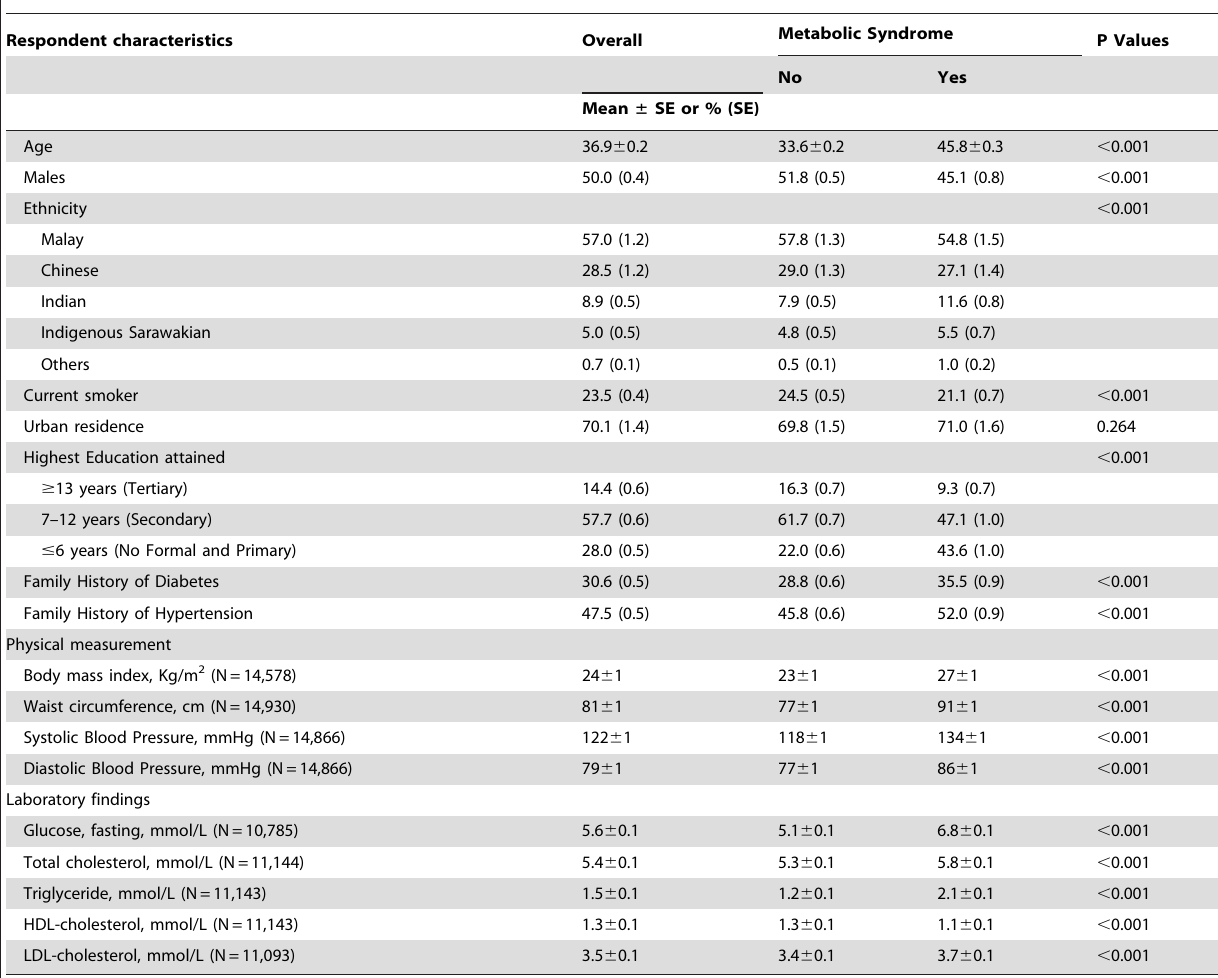
Table 1. Respondent characteristics by prevalence of metabolic